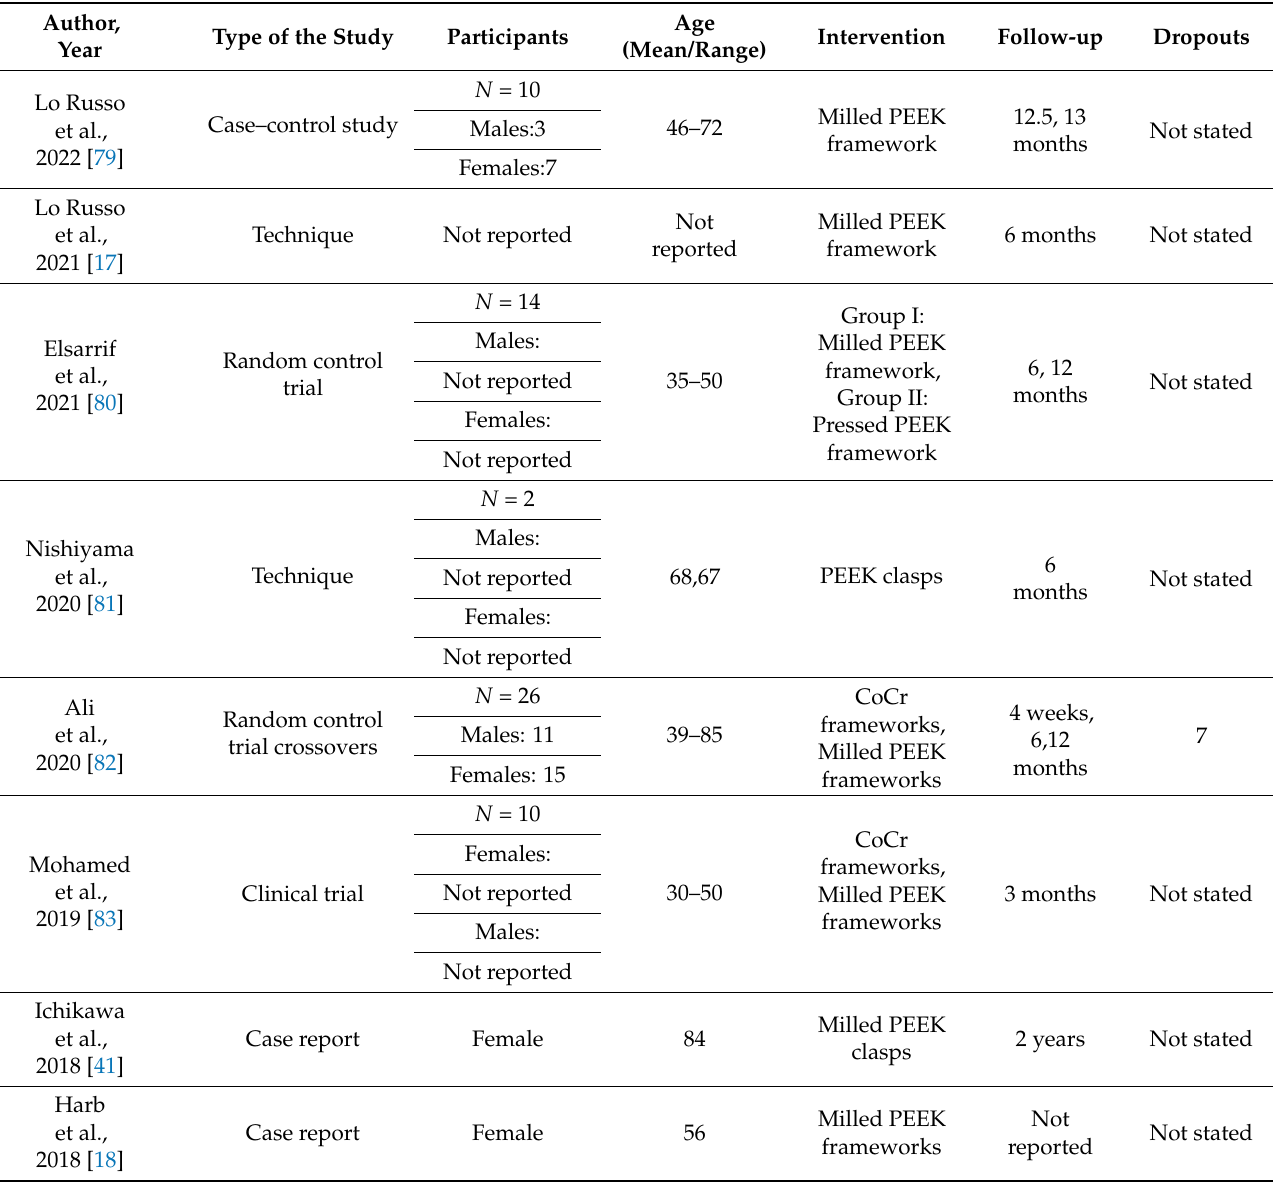
Table 1. General characteristics of clinical studies on removable partial